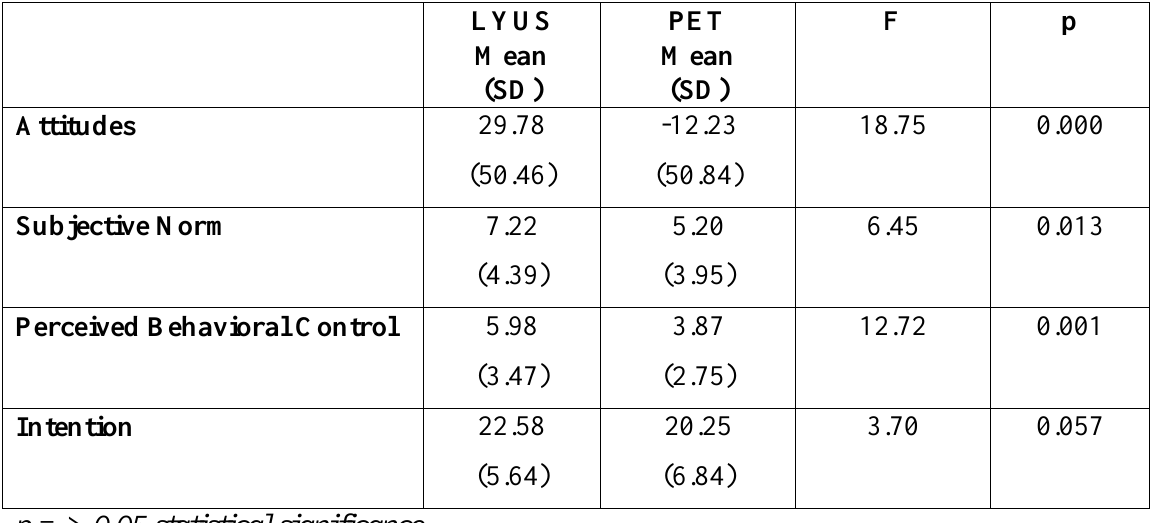
Table 5 Comparison between LYUS and